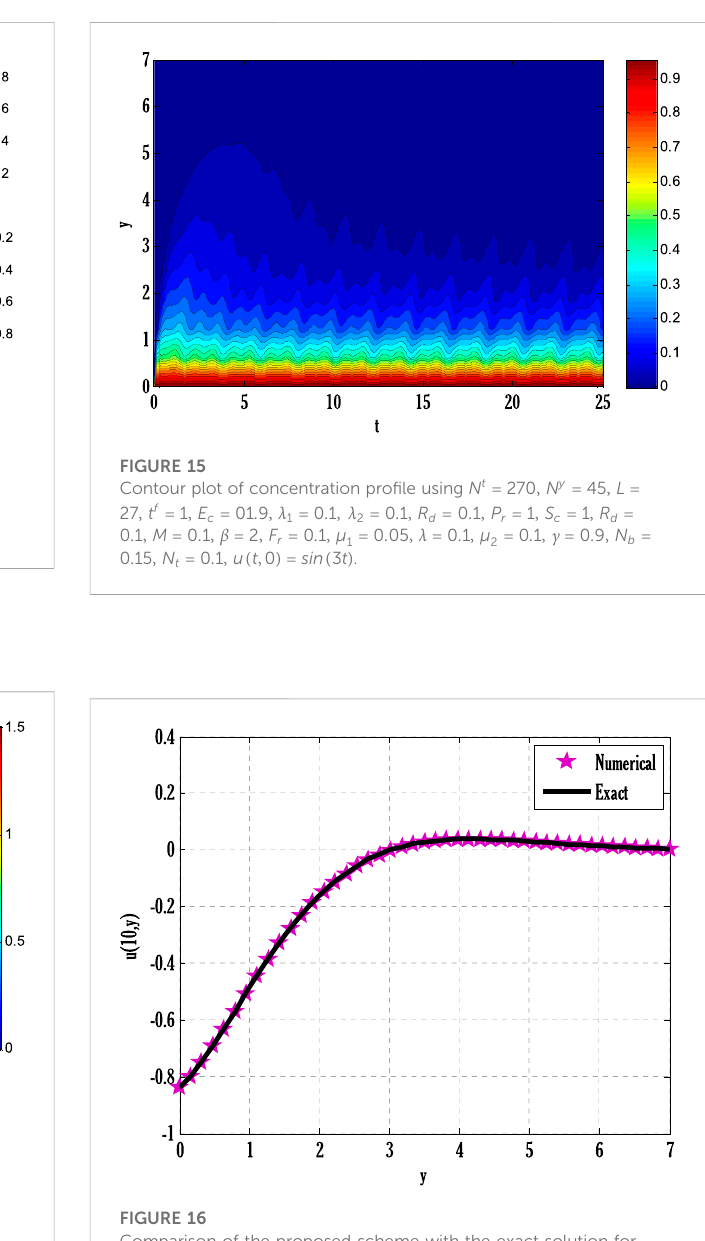
looking at this comparison given in Figure 16.